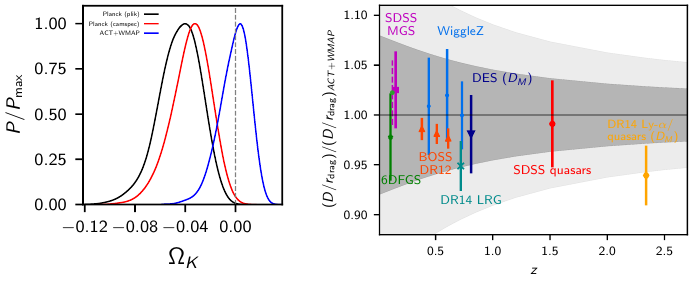
Figure 2. Comparison between Planck and ACT-DR4 ( left panel ) and ACT-DR4 and BAO ( right panel ) assuming a closed